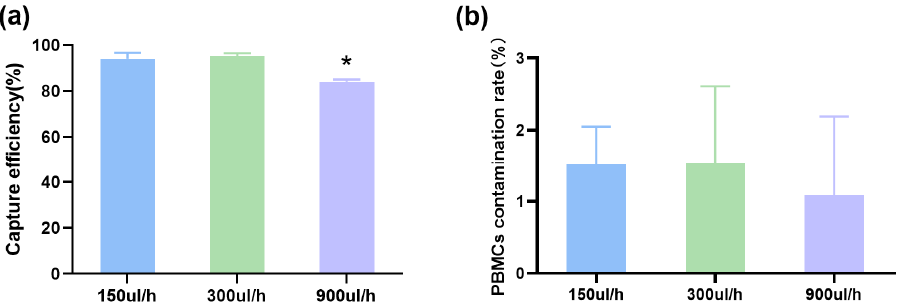
Figure 4. Effects of flow rate on the capture efficiency and contamination rate. The changes of the capture efficiency ( a ) and PBMCs contamination rate ( b ) at different flow rates were compared. * p < 0.05.